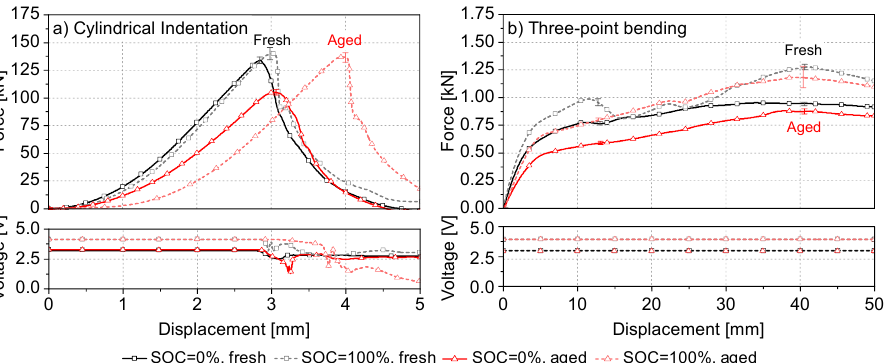
Figure 6. Comparison of the mechanical behavior of fresh and electrically aged lithium-ion cells under different load cases: ( a ) cylindrical indentation and ( b ) three-point